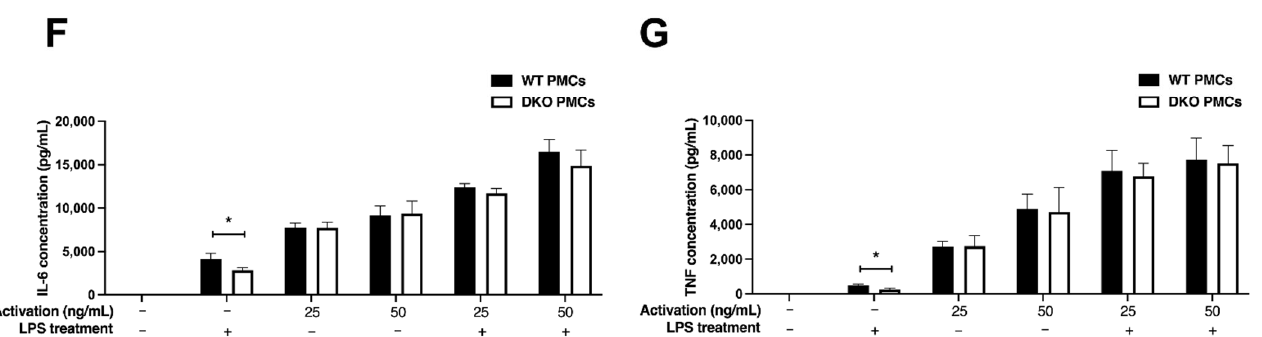
Figure 6. IRE1 activation supports cooperativity between TLR4 and Fc ε RI in CBMCs. ( A ) IgE- sensitized CBMCs were pretreated with DMSO or STF (30 or 60 µ M) for 1 h followed by activation with rabbit anti-human IgE Ab (5 µ g/mL, 4 h). Equal amounts of whole cell protein extracts were analyzed by immunoblotting for TLR4 and p97 as a loading control. RT-qPCR analysis of sensitized CBMCs after activation with rabbit anti-human IgE Ab (5 µ g/mL), stimulation with 100 ng/mL LPS, or both treatments for 4 h, for ( B ) sXBP1, ( C ) TNF, and ( D ) IL-6. Bars represent the mean of relative mRNA levels normalized to β -actin ± SD of three independent experiments. * p < 0.05. ( E ) IgE-sensitized CBMCs were pretreated with DMSO or STF (60 µ M) for 1 h followed by activation with rabbit anti-human IgE Ab (5 µ g/mL), 100 ng/mL LPS, or both for 4 h. IL-6 levels in the super- natants were quantified by ELISA. Bars represent the mean ± SD of three independent experiments. * p < 0.05. PMCs were sensitized overnight with mouse IgE-anti-DNP (0.5 µ g/mL, 18 h). Later, cells were stimulated with 100 ng/mL LPS, activated with DNP-BSA (25 or 50 ng/mL), or stimulated with both for 4 h. Levels of IL-6 ( F ) and TNF ( G ) in supernatants were determined by ELISA. Each bar represents the mean ± SD of three independent experiments. * p <